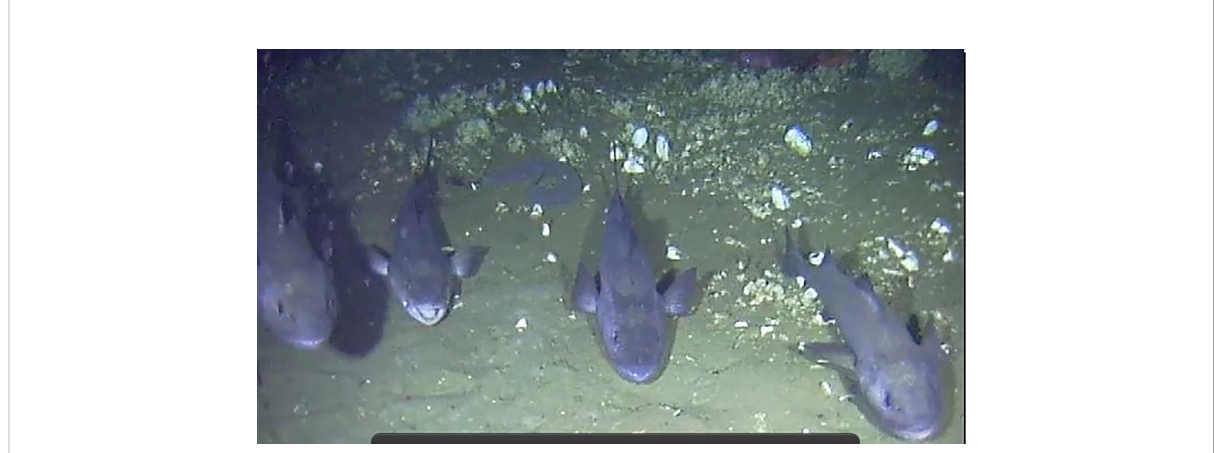
FIGURE 8 Group of sable fi sh, resting in front of the crawler. Fish are attracted by the blue light of a WetLabs fl uorometer, which creates a light stream onto the